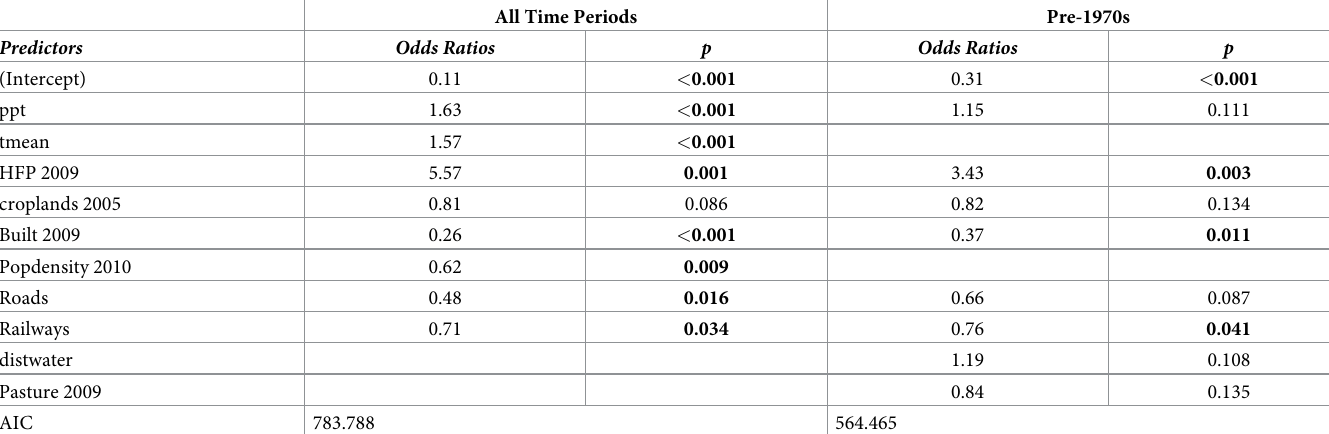
Table 2. Lowest AIC models for stepwise binomial logistic regression.